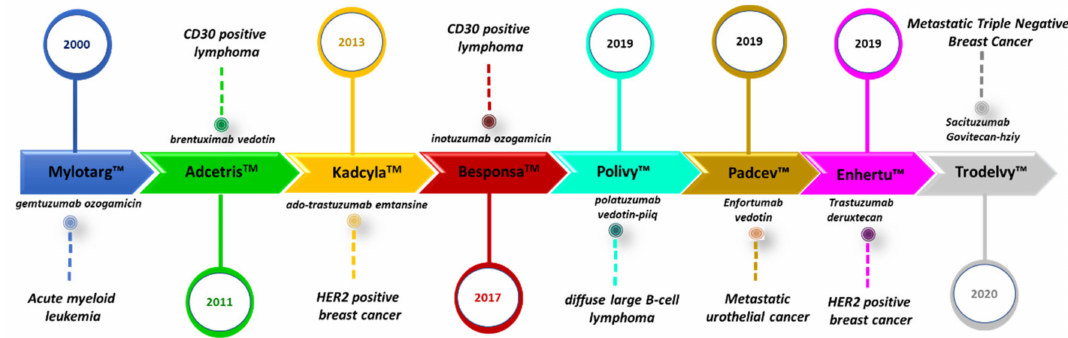
Figure 1. Antibody-drug conjugates (ADCs) approved by the Food and Drug Administration